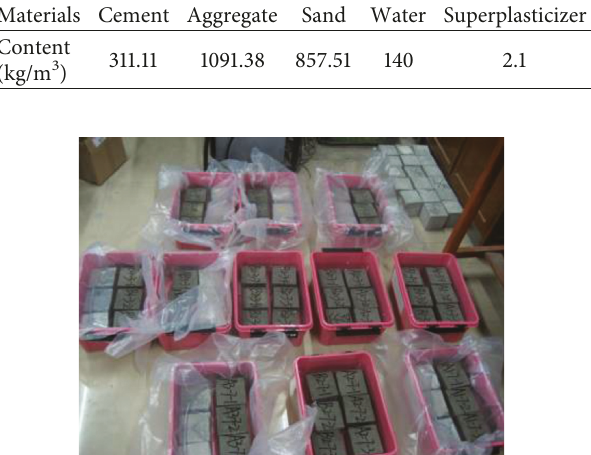
Figure 1: Concrete specimens exposed to drying-wetting cycles with sulfate attack.